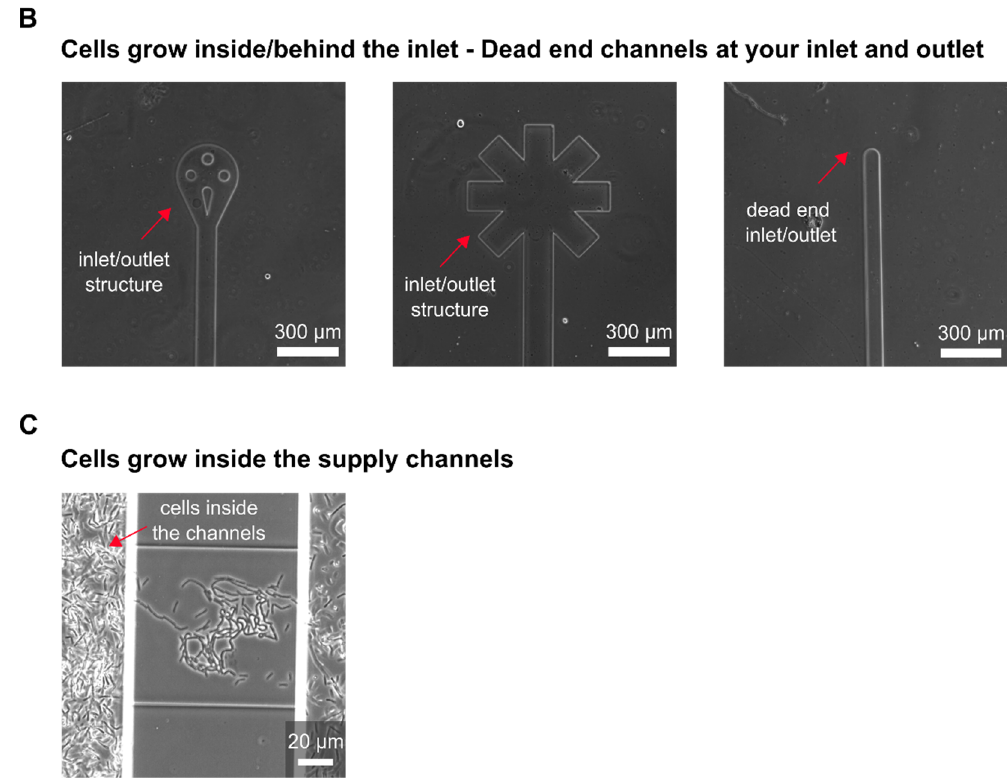
Figure A6. Example images of undesired growth locations (see Table 8). Microscope images of ( A ) cells grow inside/behind the inlet, ( B ) in different inlet structures and ( C ) cells grow inside the supply channels.